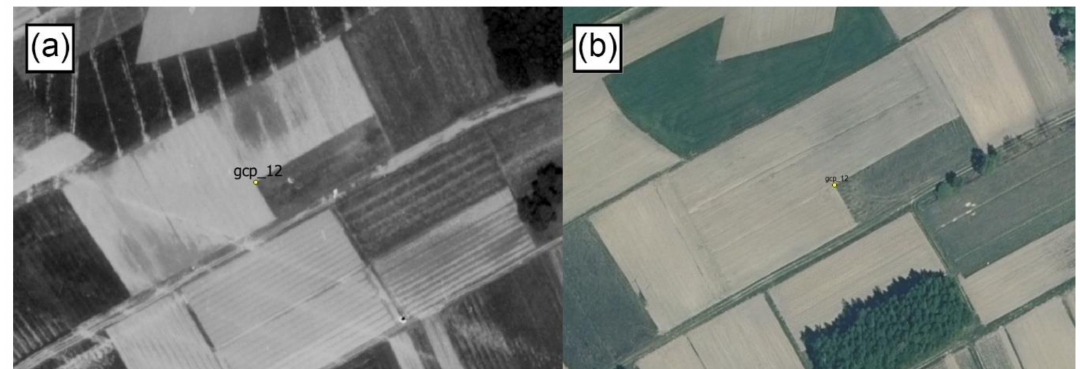
Figure 2. An example of the identification of ground control point located in the corner of the land parcel which did not change over the years. Both in 1966 ( a ) and 2012 ( b ), the boundary of the cadastral parcel overlapped the boundary of